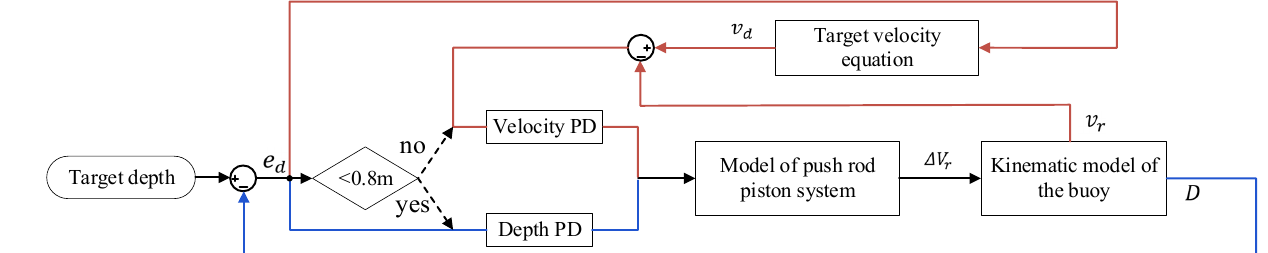
Figure 3. Schematic diagram of segment PD control.